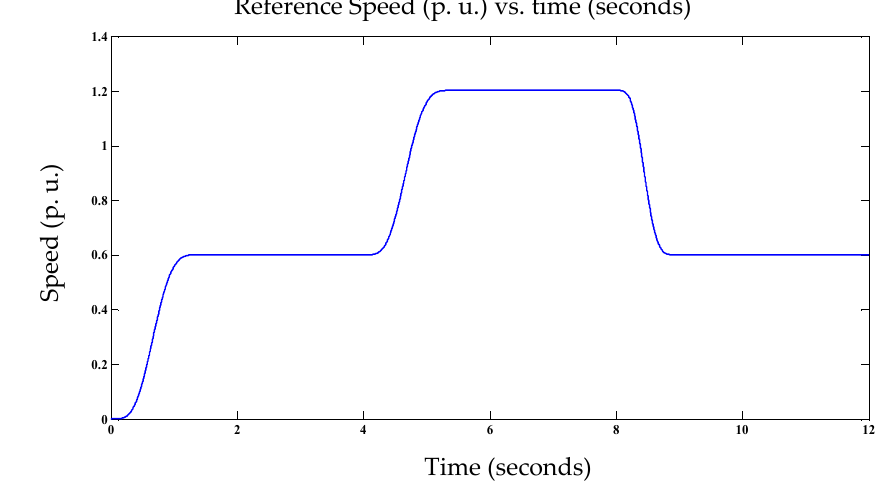
Figure 7. Speed reference profile.